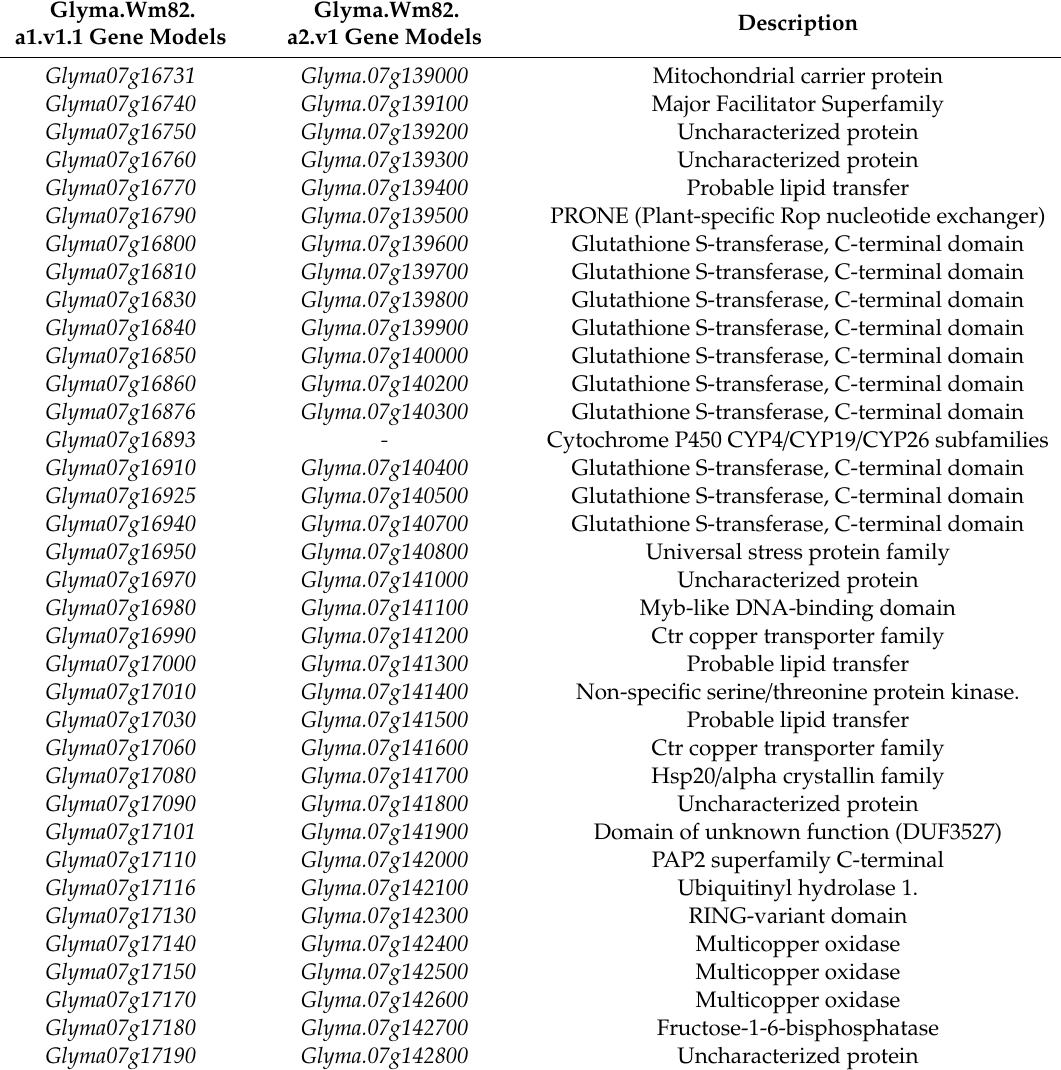
Table 2. List of gene models in the 550.5-Kb physical interval of the derived short-petiole1 ( dsp1 ) locus.